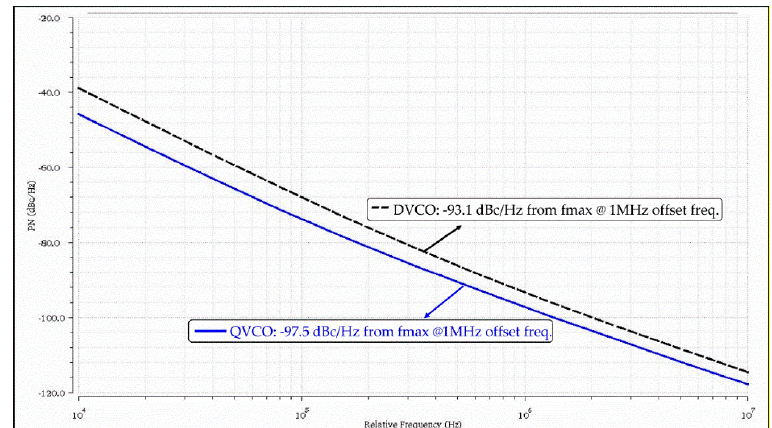
Figure 10. (cid:1842)(cid:1840) plot of DVCO and QVCO at an offset range from 10 KHz to 10 MHz highlighting (cid:1842)(cid:1840)(cid:1871) Figure 10. PN plot of DVCO and QVCO at an offset range from 10 KHz to 10 MHz highlighting PNs from their corresponding maximum carriers. from their corresponding maximum carriers. Electronics 2018 , 7 , x FOR PEER REVIEW